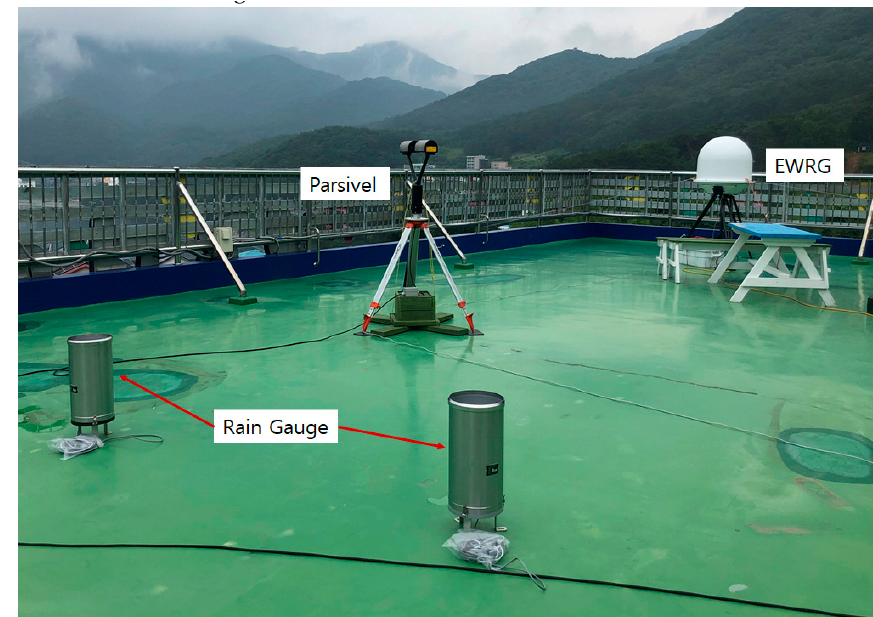
Figure 9. Layout of the EWRG comparative test site at Geoje.